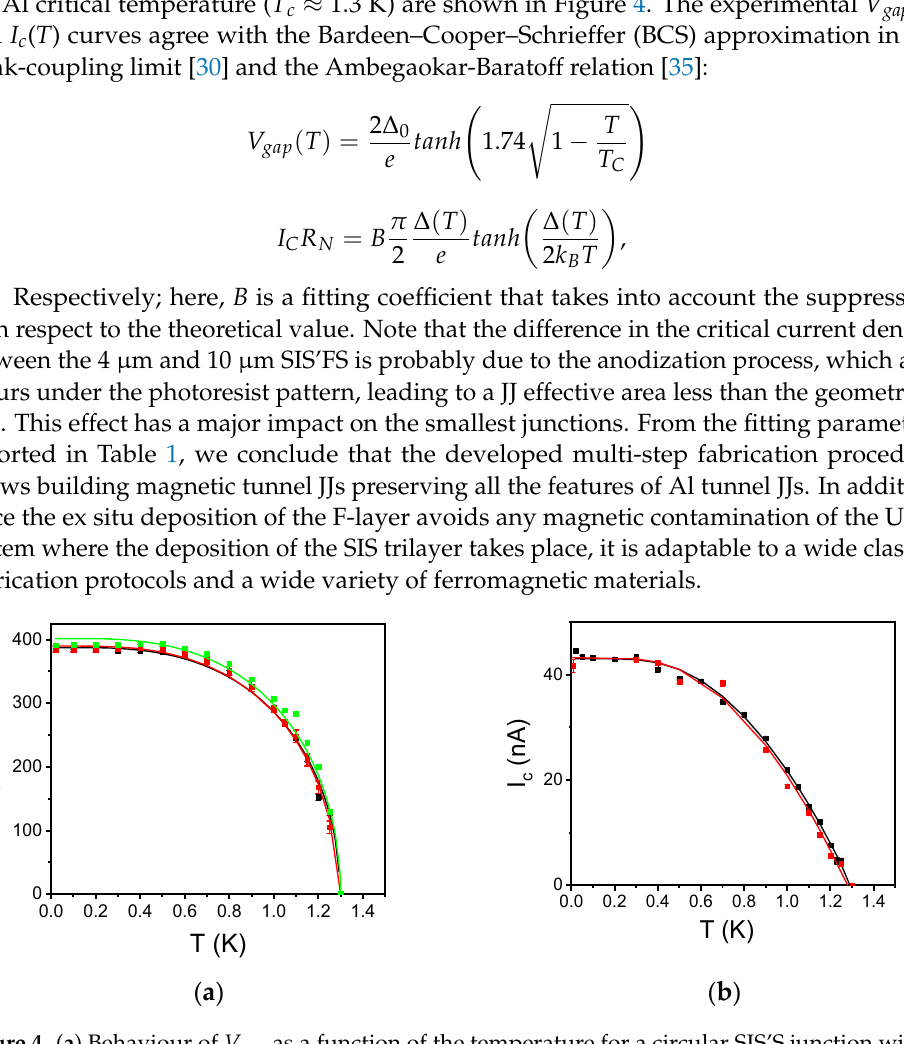
Figure 4. ( a ) Behaviour of V gap as a function of the temperature for a circular SIS’S junction with a diameter of 4 µ m (dark curve), and SIS’FS junctions with a diameter of 4 µ m (red curve) and 10 µ m (green curve), respectively. The solid curves are the fitting curves calculated by using Equation (1). ( b ) Behaviour of critical current I c as a function of the temperature for a circular SIS’S junction with a diameter of 4 µ m (dark curve) and SIS’FS junctions with a diameter of 4 µ m (red curve). The solid curves are the fitting curves calculated by using Equation